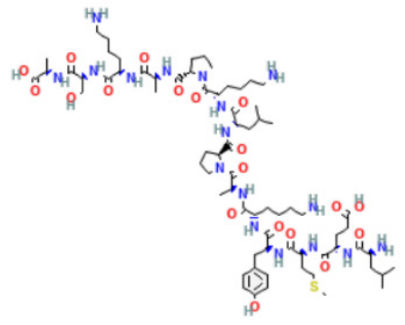
Figure 22. Chemical structure of IGF-1. Formula: C 71 H 119 N 17 O 19 S.